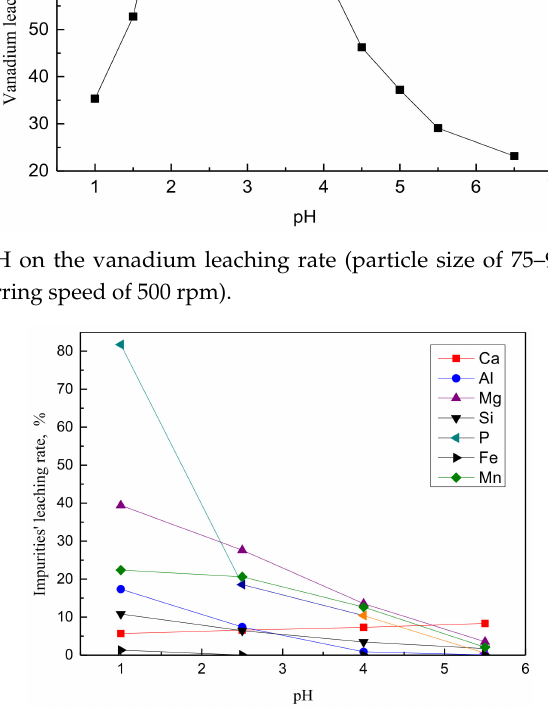
Figure 6. Effect of pH on the leaching rate of impurities (particle size of 75–96 µ m, time of 60 min, T = 65 ◦ C, L / S = 4, stirring speed of 500